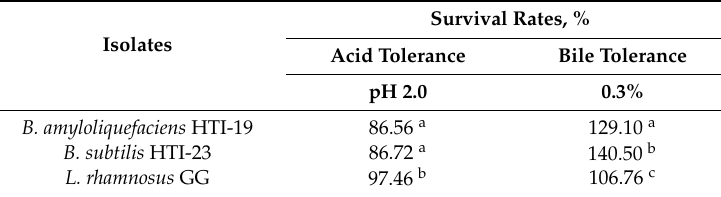
Table 3. The survival of selected probiotic Bacillus isolates in simulated gastrointestinal